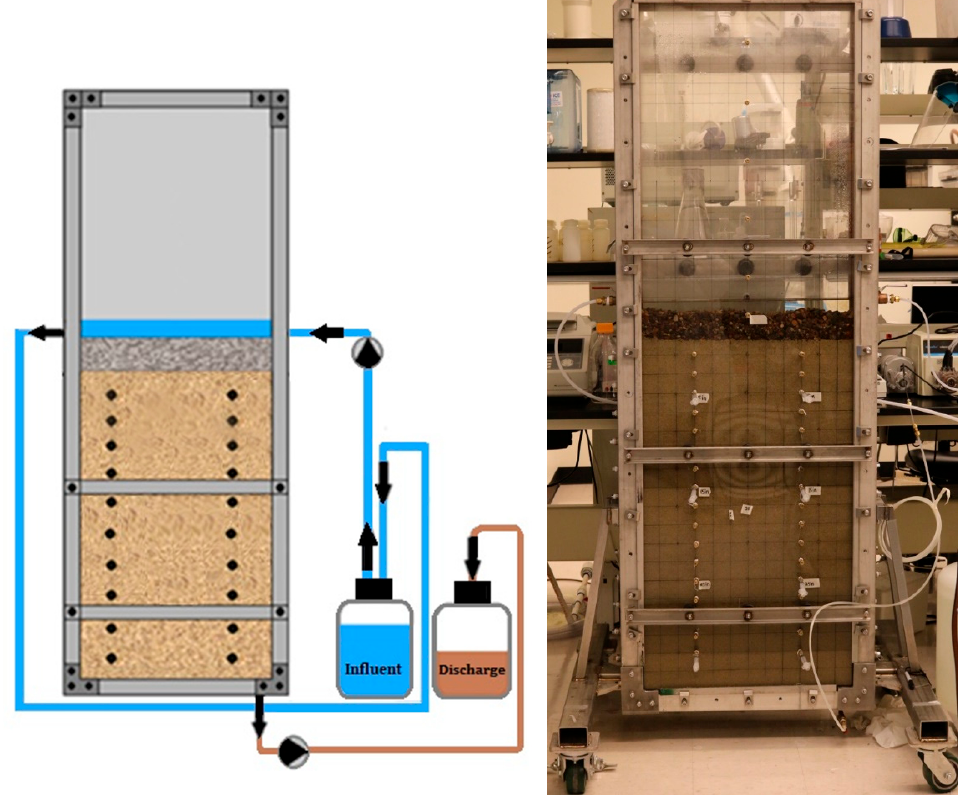
Figure 1. A schematic (not to scale) and a photo of the 2-D tank packed with Sakrete © play sand media with sampling ports. Note: A 3 inch gravel pack is not visible at the base of the sand pack but is present to provide uniform effluent drainage across the tank.